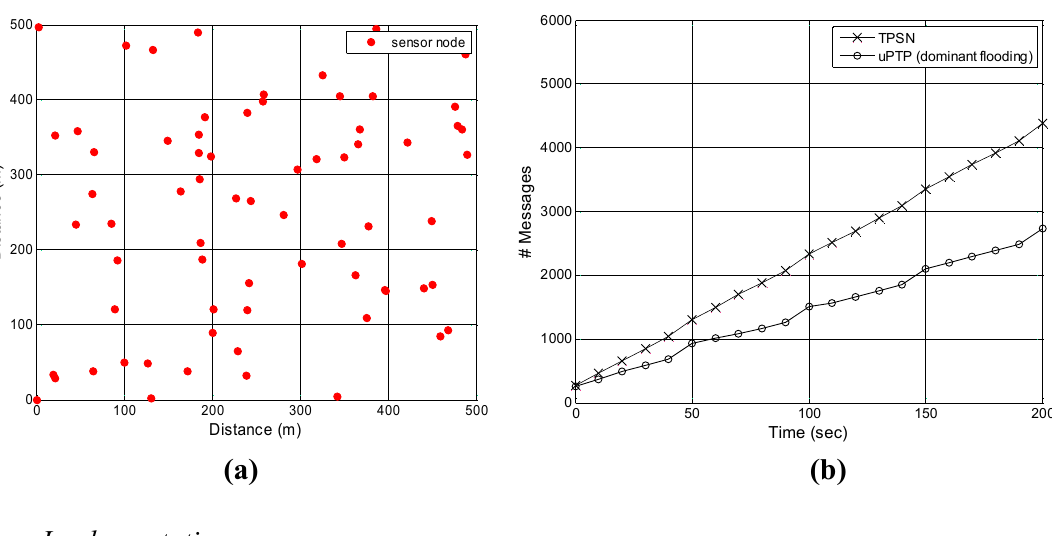
Figure 11. Number of messages vs. time advancement. (a) sensor topology; (b) number of